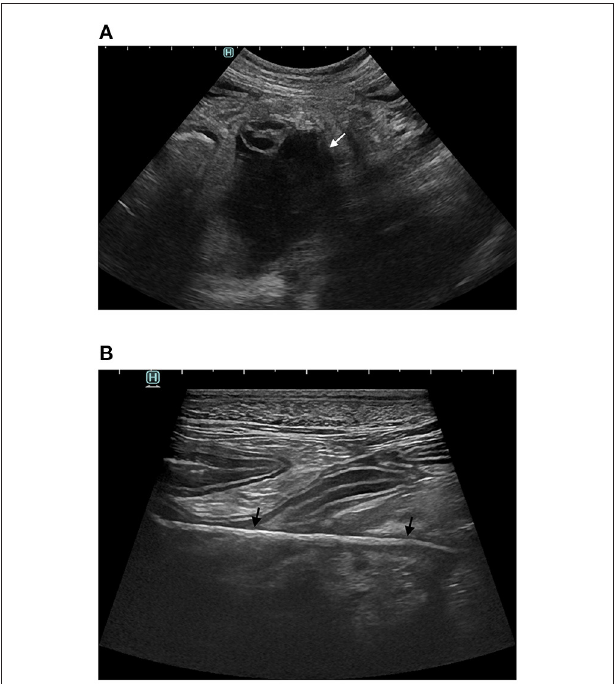
FIGURE 2 | Abdominal ultrasound of D2. (A) Echoic fluid filled cavity (white arrow) along a small bowel loop (B) Perforating intestinal stick-like foreign body (black